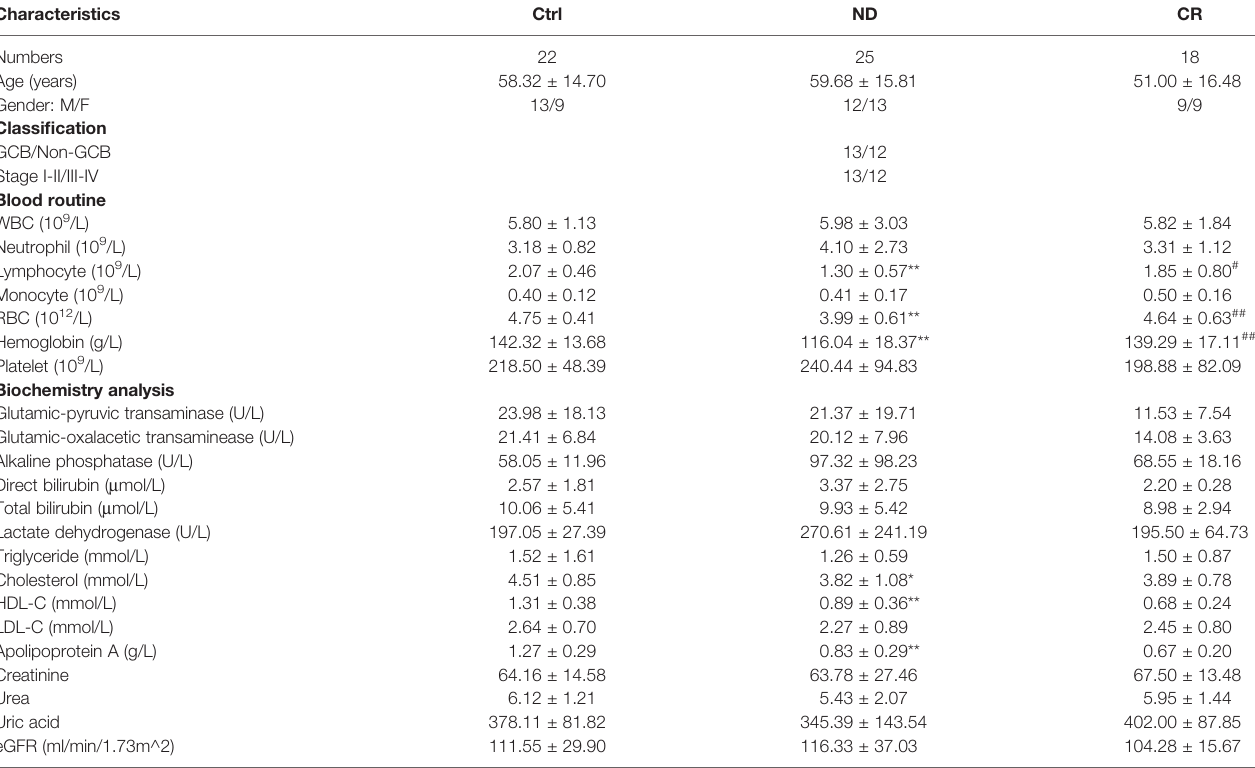
TABLE 1 | The demographics and clinical characteristics of DLBCL patients and healthy